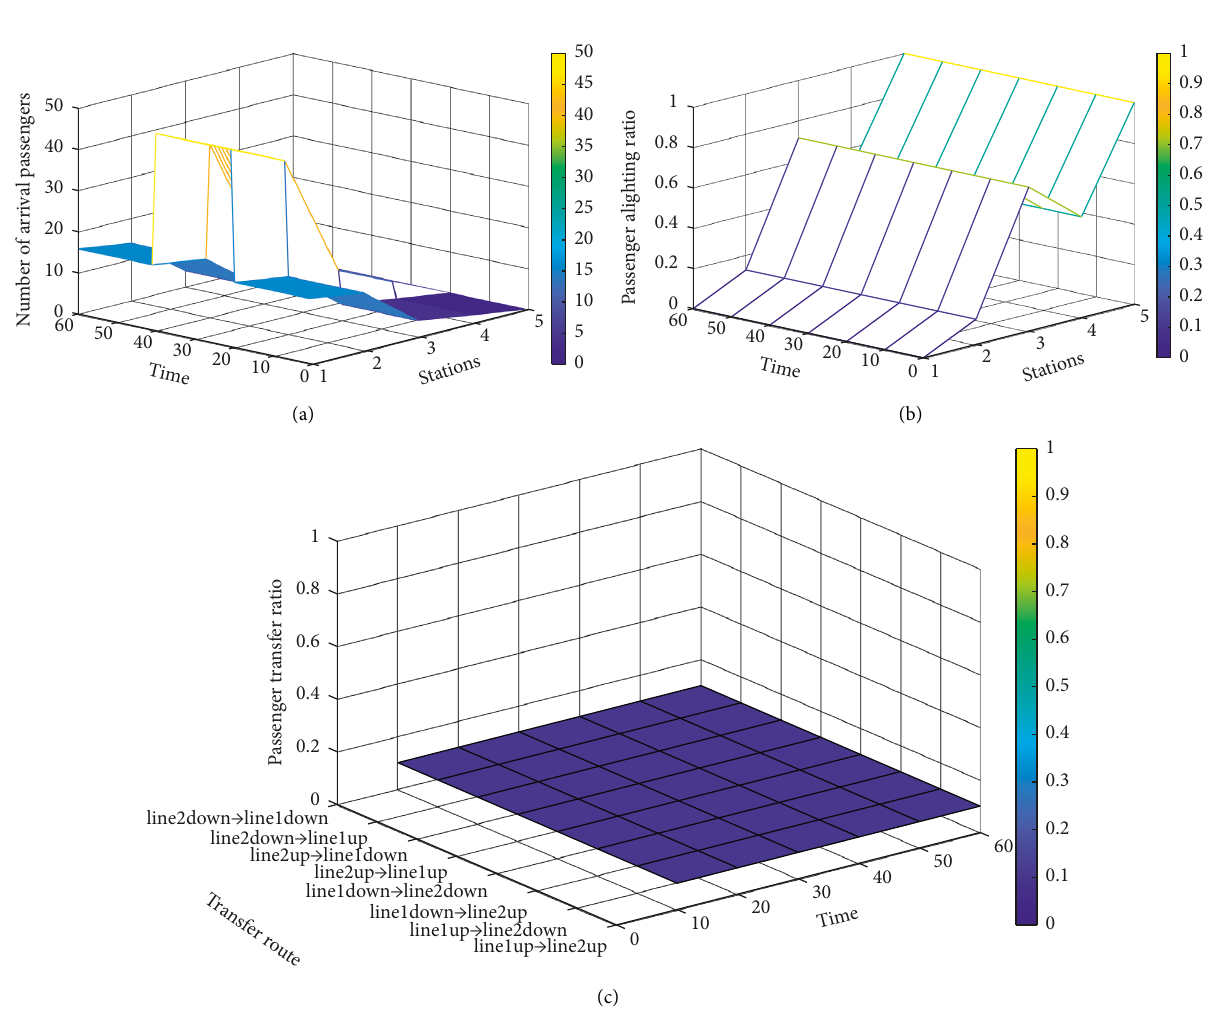
Figure 18: The passenger demand distribution in numerical case. (a) PAS i ( t ) , (b) PRA i ( t ) , and (c) PRT i,i ′ ( t )